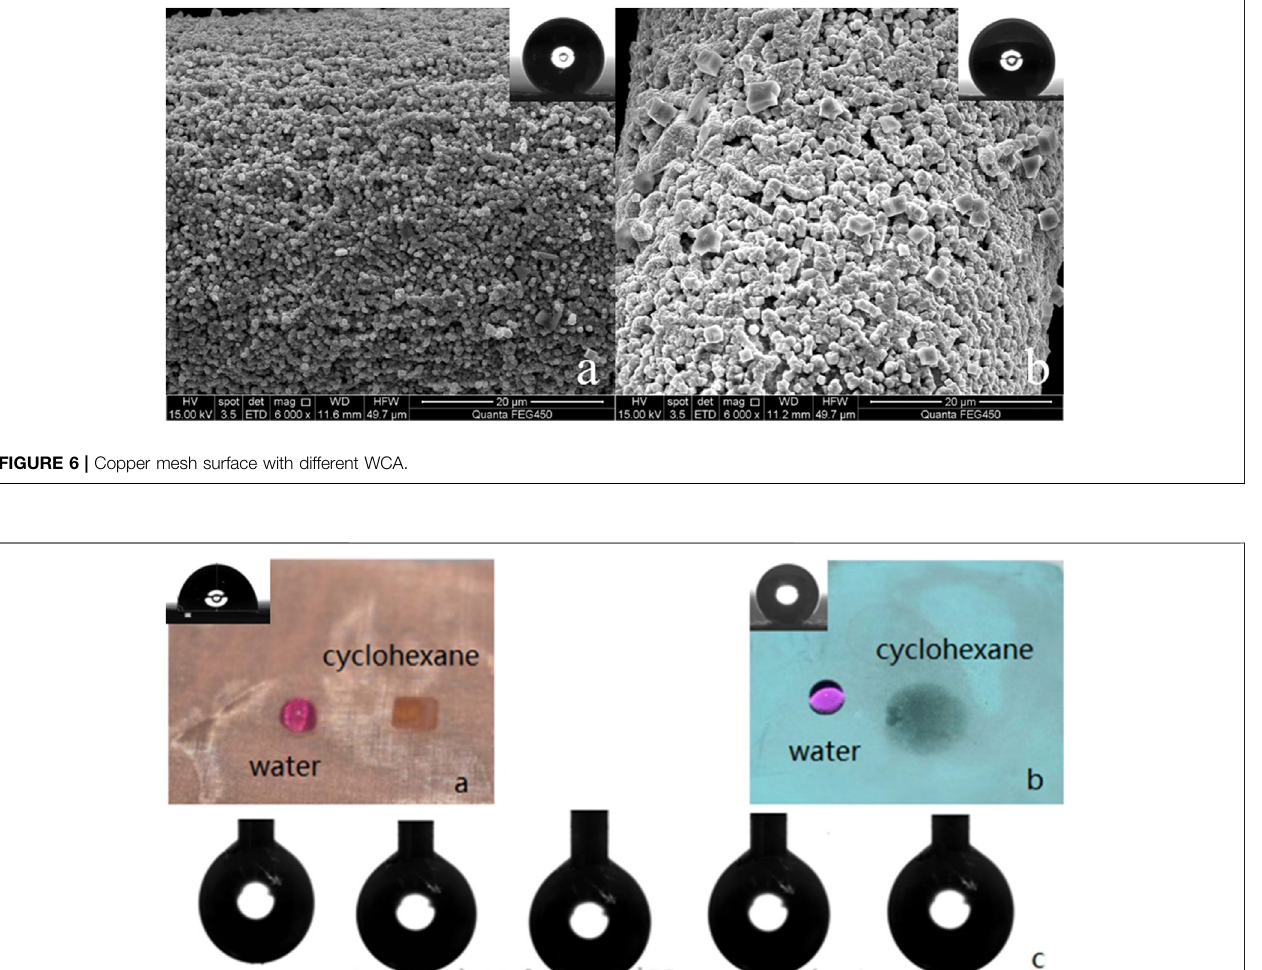
Frontiers in Chemistry |